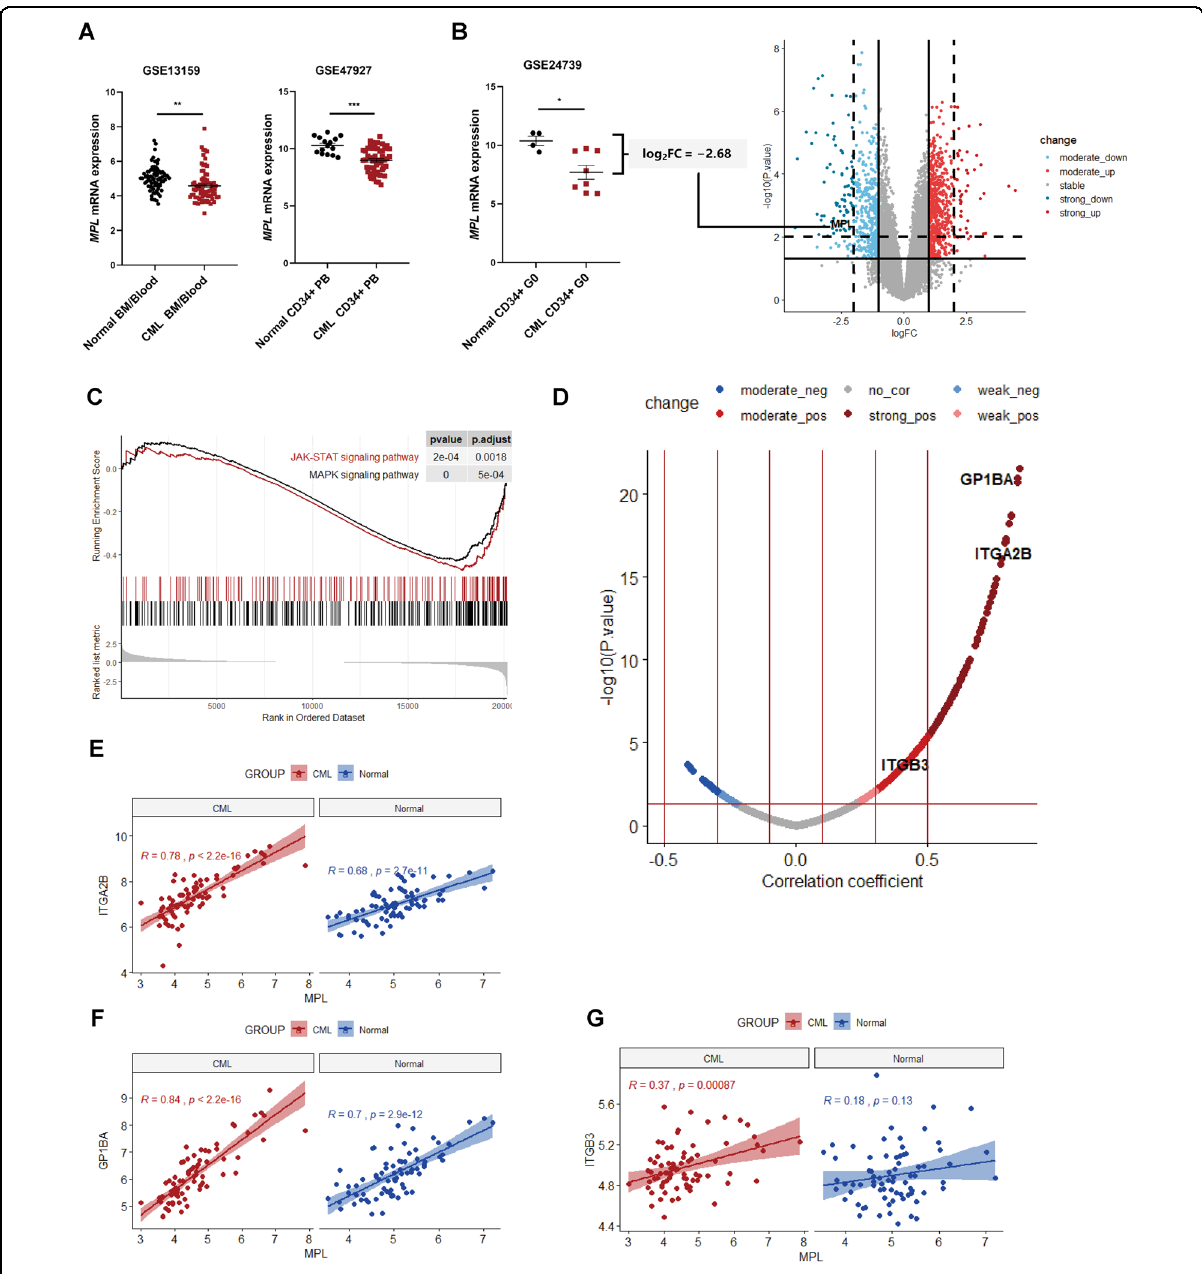
Fig. 1 MPL was involved in differentiation arrest of CML cells. A MPL expression levels of CML samples and their normal controls in GEO accession including GSE13159 ( n normal = 74, n CML = 76), GSE47927( n normal = 15, n CML = 52). B MPL expression levels and volcano plot of differential gene pro fi les between normal ( n = 4) and CML ( n = 8) CD34 + quiescent cells (GSE24739). Criteria to fi lter DEGs were absolute log 2 FC >1 & P value <0.05 (as the solid lines showed), the high-threshold to shrink DEGs was de fi ned as absolute log 2 FC >2 & P value <0.01 (as the dashed lines showed). MPL was labeled in the volcano plot. C GSEA showing negative enrichment of JAK/STAT, MAPK pathways gene signatures. Genes were ranked by log 2 FC. D Volcano plot of correlations between MPL and the other detected genes in CML samples (GSE13159, n = 76). X-axis represented the Pearson coef fi cients and the Y-axis showed negative log10 of the P values. The correlations between MPL and three MK marker genes, including ITGA2B , GP1BA, and ITGB3 , were labeled in the volcano plot and further visualized by correlation plots ( E – G ). Error bars indicated mean ± standard error of the mean (SEM) ( P values: two-tailed Student ’ s t test; * P <0.05, ** P <0.01, *** P